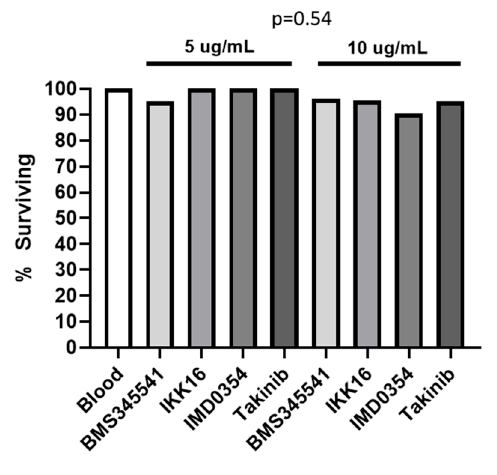
Figure 3. Seven-day survivorship of bed bugs fed NF-kB signaling inhibitors. Inhibitors were dissolved in DMSO and diluted in a blood meal to a final concentration of 5 µ g/mL or 10 µ g/mL. Shown is cumulative survival from 2 independent biological replicates of 10–15 adult insects per treatment group assessed 7 days post-feeding. Differences between treatment groups were not statistically significant as determined by Chi-square testing.